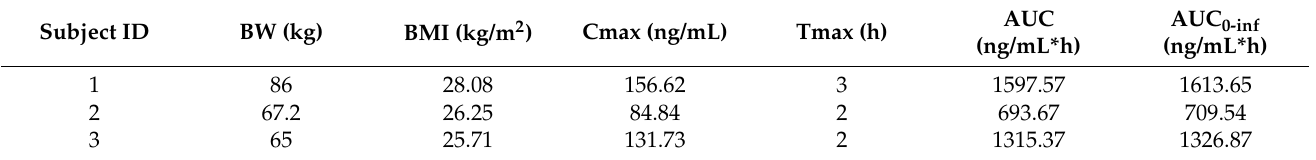
Table 4. Pharmacokinetic parameters of PQ and 5,6-PQ in human urine ( n = 3).